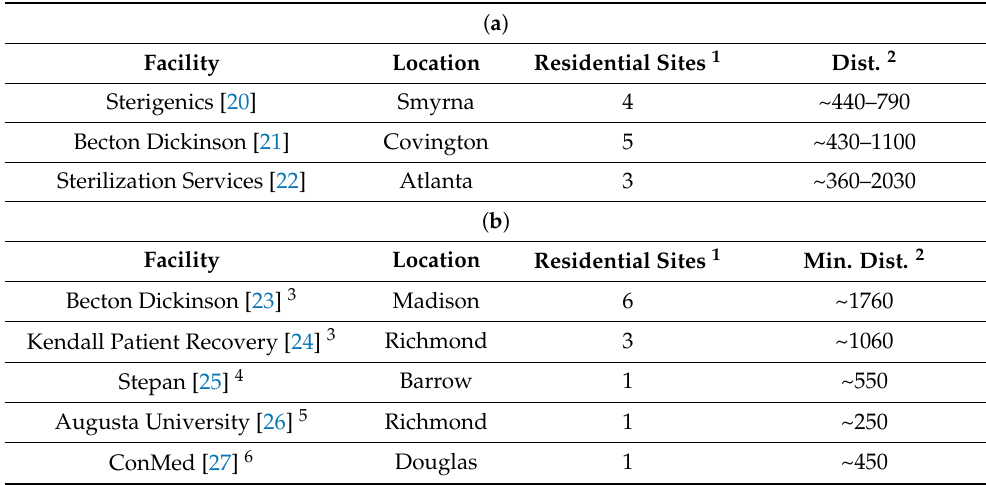
Table 2. ( a ). Summary of publicly available datasets concerning modeling of facility-specific ambient air EO concentrations in Georgia in the vicinity of three sterilization facilities. ( b ). Summary of publicly available datasets concerning modeling of facility-specific ambient air EO concentrations in Georgia in the vicinity of additional facilities.